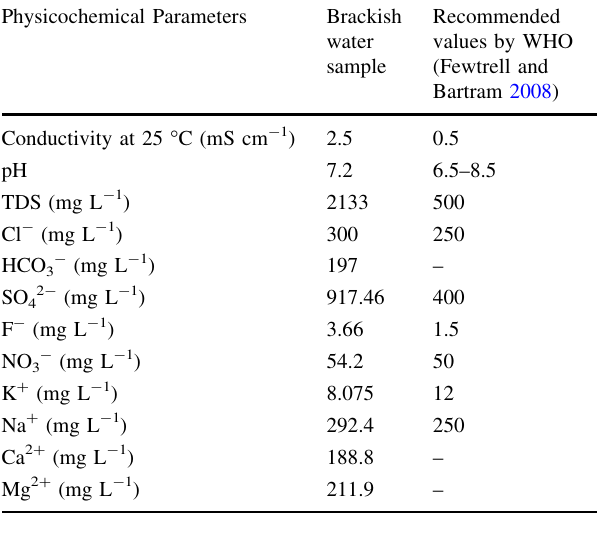
Table 1 Physicochemical characteristics of brackish water sample Physicochemical